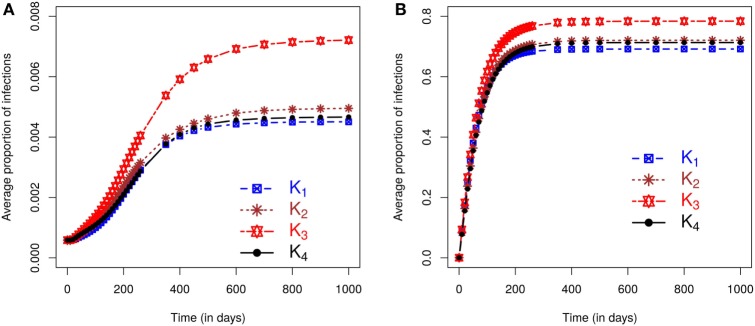
Posterior predicted average proportion of premises infected plotted as a function of time. On each graph, the lines correspond to the results obtained when kernels K1 − K4 are fitted to the CSF data with final sizes (A) smaller or (B) larger than the mean of the final size distribution.